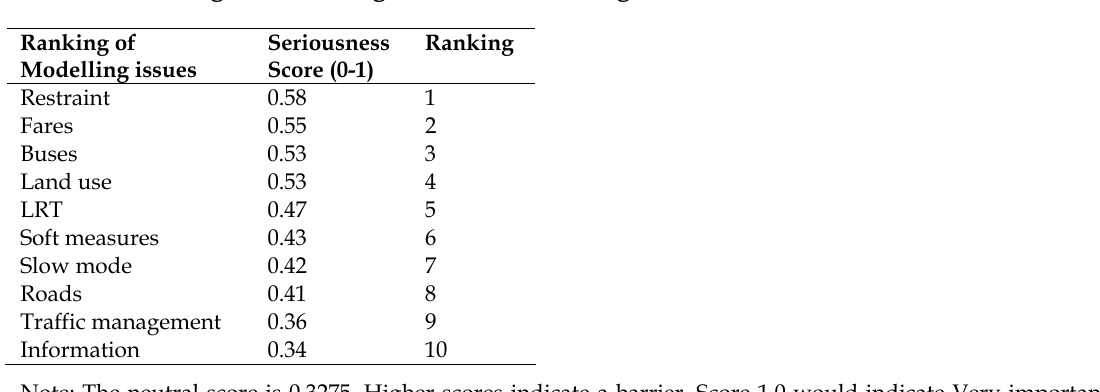
Figure 1. The importance and satisfaction of modelling specific types of instruments. Table 1. Ranking of modelling issues and enabling